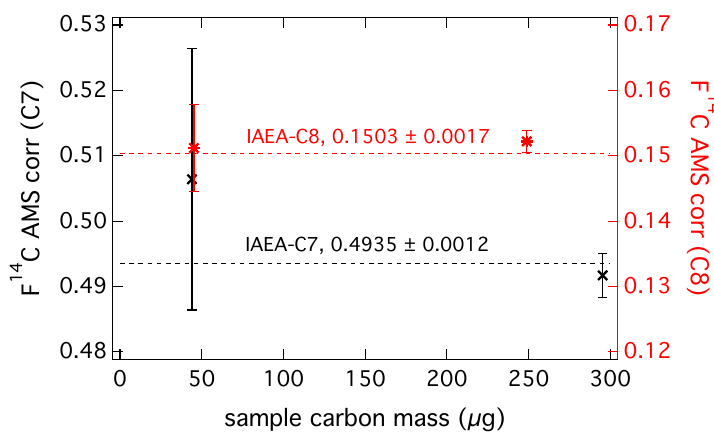
Figure A3. F 14 C of secondary standards IAEA-C7 and IAEA-C8 measured at CIO with applied AMS corrections (normalization, correction for isotopic fractionation and background contamination correction) in dependence of sample carbon